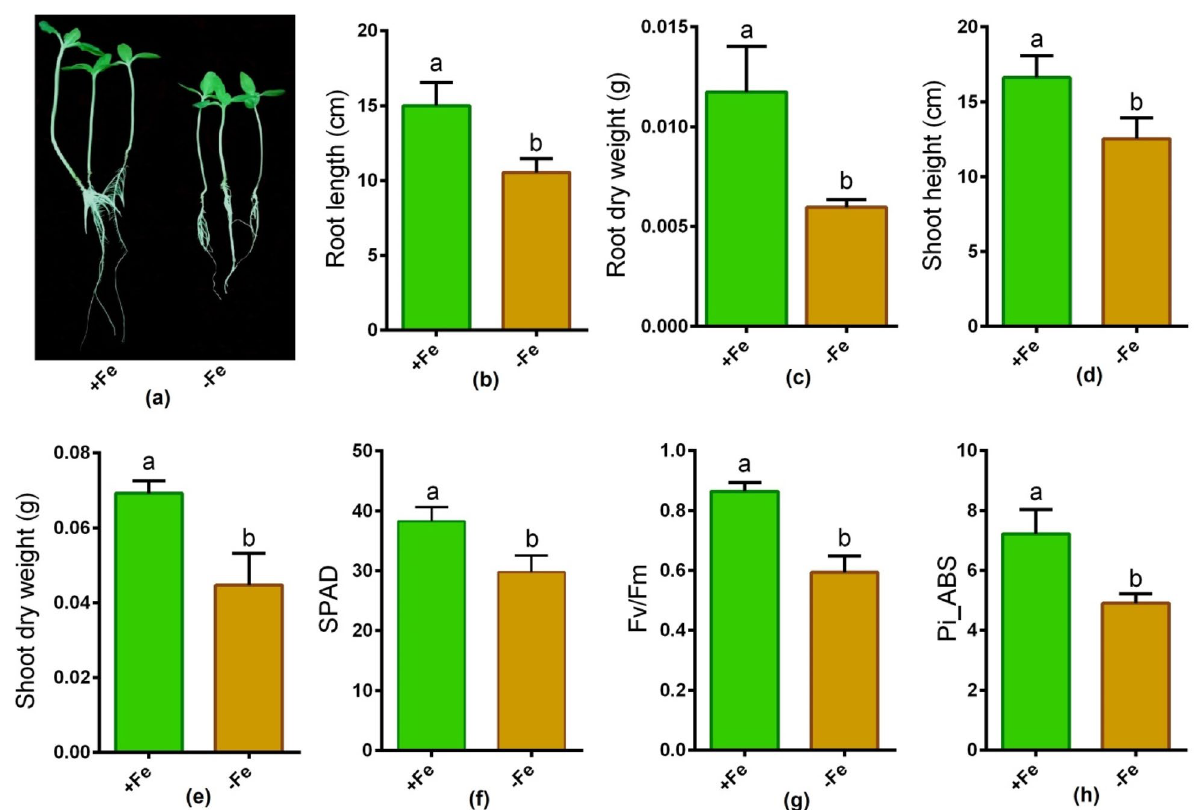
Figure 1. Plant phenotype ( a ), root length ( b ), root dry weight ( c ) shoot height ( d ), shoot dry weight ( e ), SPAD ( f ), Fv/Fm ( g ) and Pi_ABS ( h ) in sunflower cultivated under Fe-sufficient and Fe-deficient conditions. Different letters in each column indicate significant differences between means ± SD of treatments (n = 3) at a P < 0.05 significance level.